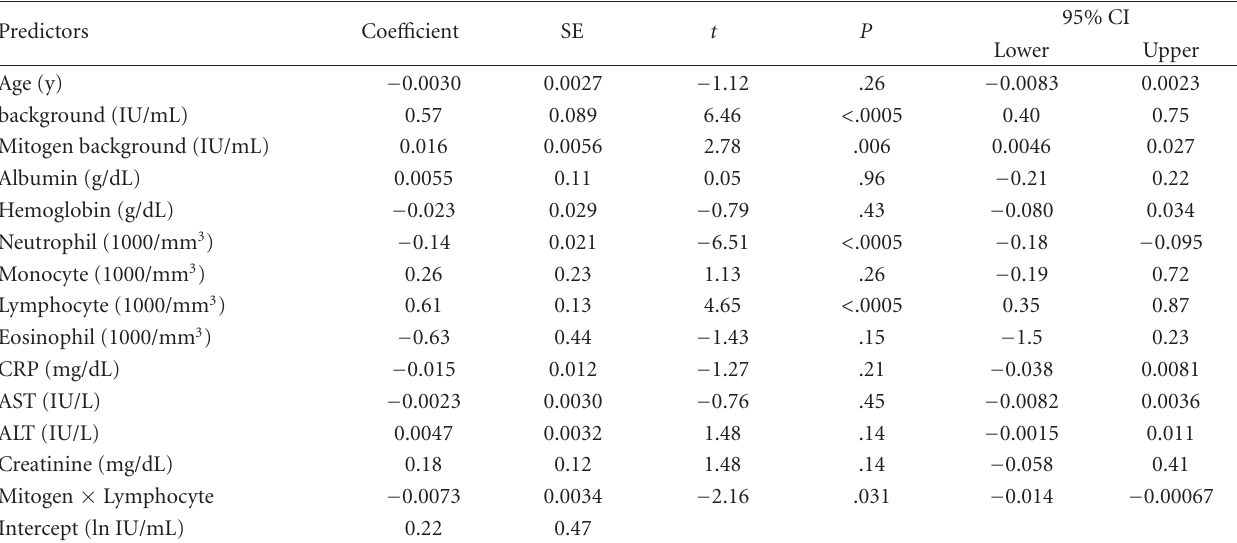
Table 2: Regression coe ffi cients and associated statistics.